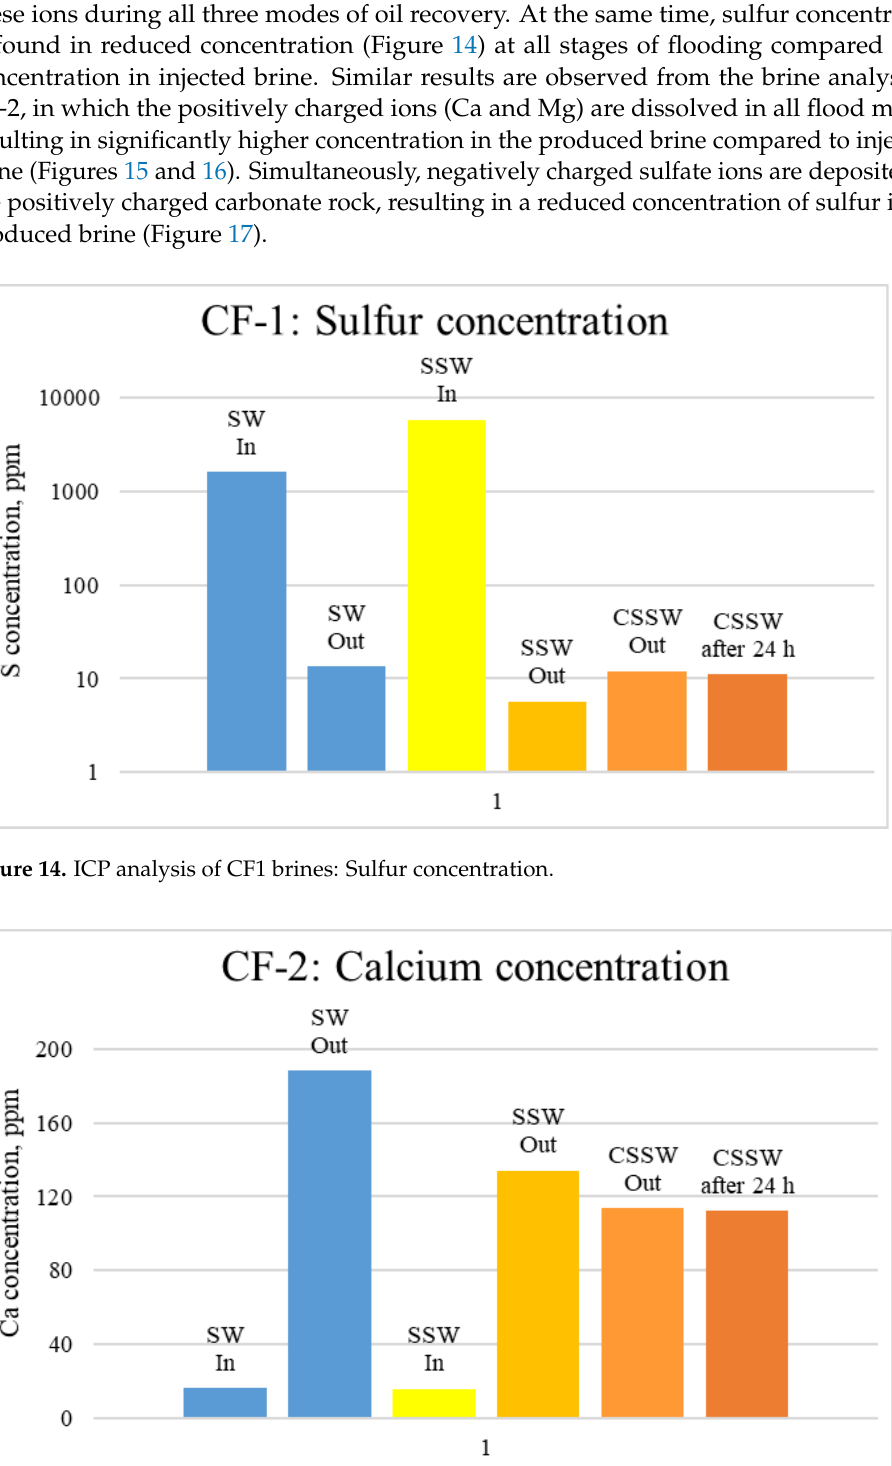
Figure 15. ICP analysis of CF-2 brines: Calcium concentration.